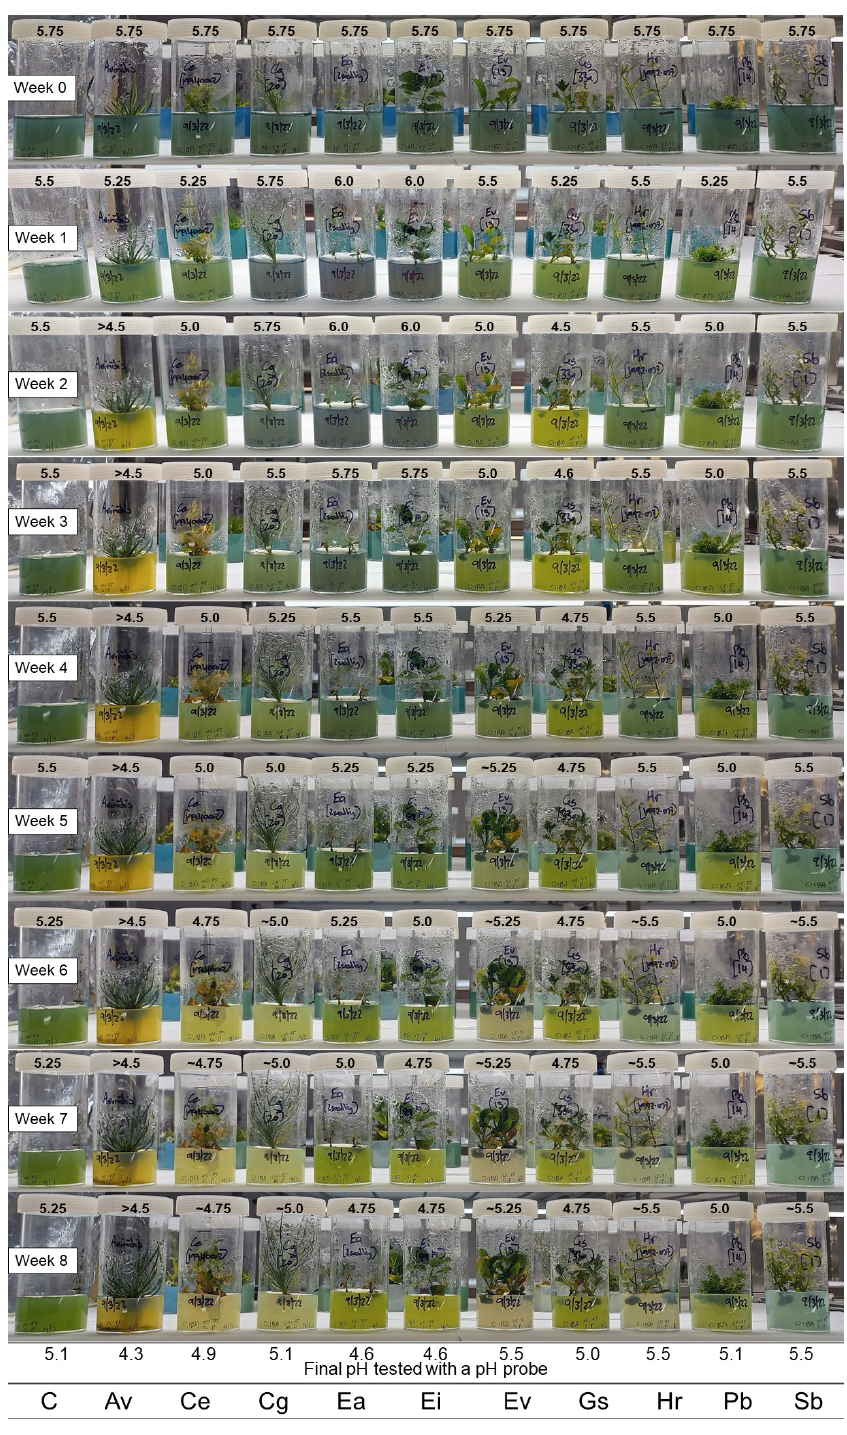
Figure 3. Visual change in pH of the medium with a 1:3 bromocresol green (BCG):bromocresol purple (BCP) combination used at a concentration of 10 µg mL − 1 over an eight week period. Initial pH of the medium was approximately 5.75, visual estimation of pH based on the colour given above each jar. The symbol ~ denotes pH indicator colour fading in medium, making visual pH estimation difficult. Control (C), Anigozanthos viridis (Av), Commersonia erythrogyna (Ce), Conospermum galeatum (Cg), Eucalyptus argutifolia (Ea), Eucalyptus impensa (Ei), Eremophila virens (Ev), Grevillea scapigera (Gs), Hemiandra rutilans (Hr), Philotheca basistyla (Pb), and Symonanthus bancroftii (Sb).